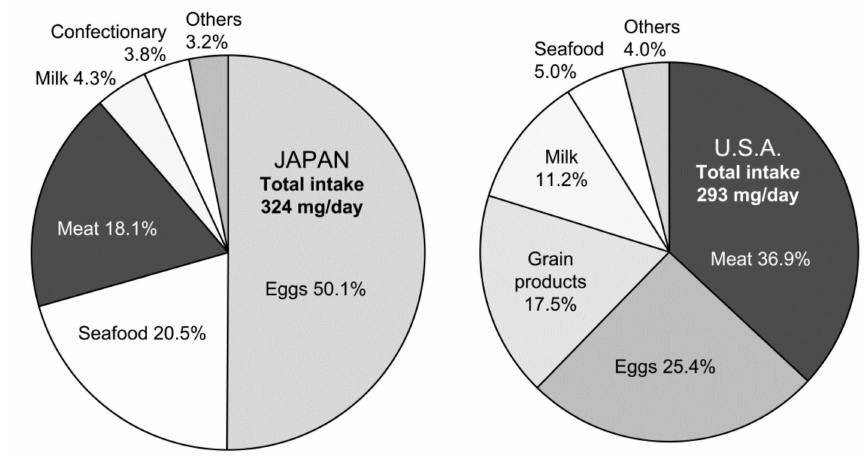
Figure 1. Dietary sources of cholesterol in Japanese and US populations. Japanese data are from the National Health and Nutrition Survey, 2017 (Ministry of Health, Labor and Welfare, Japan), and the US data are from the National Health and Nutrition Examination Survey, 2003–2014